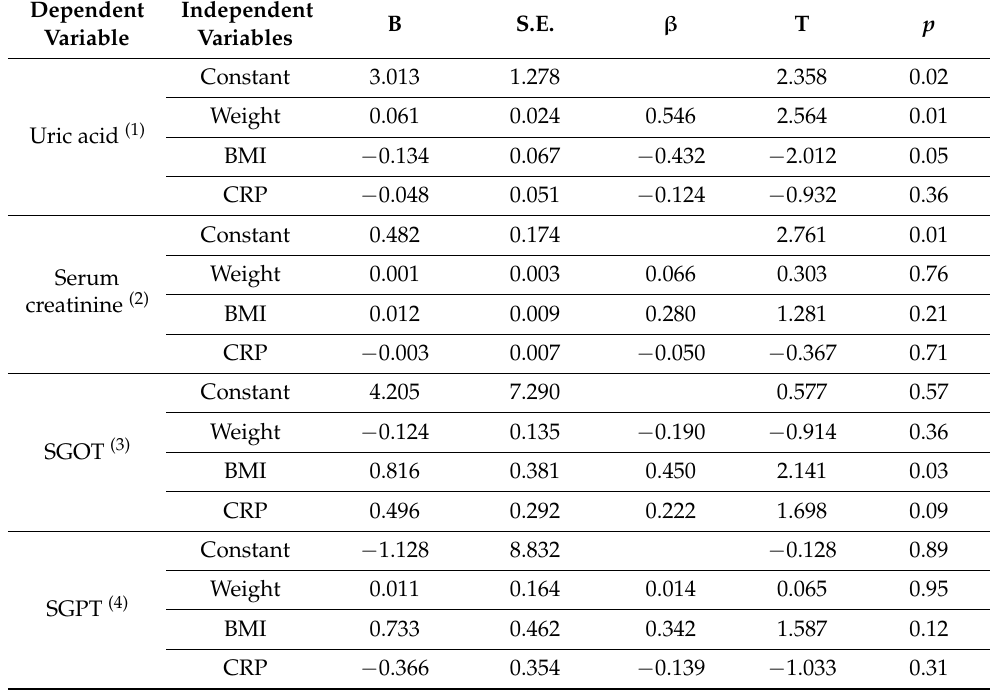
Table 4. Regression analysis of specific factors for the forensic psychiatric patients taking second- generation antipsychotics with a higher risk of weight gain